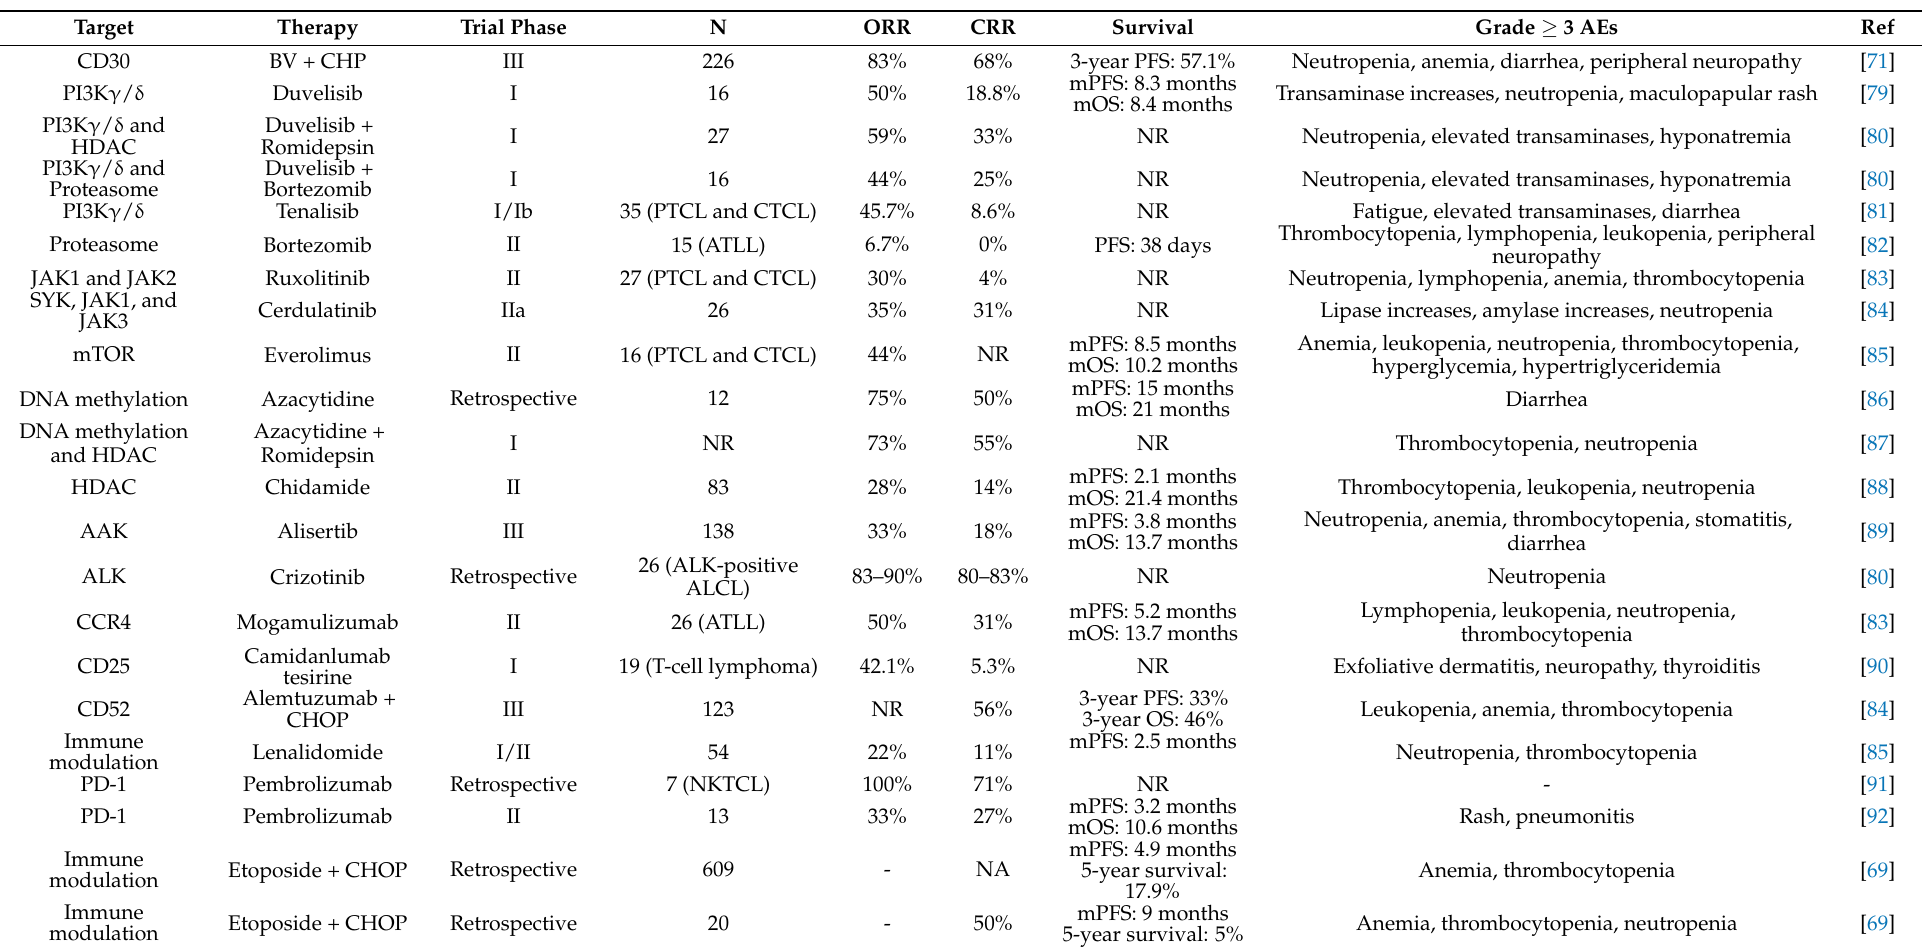
Table 2. Results of clinical trials of targeted agents for the treatment of peripheral T-cell